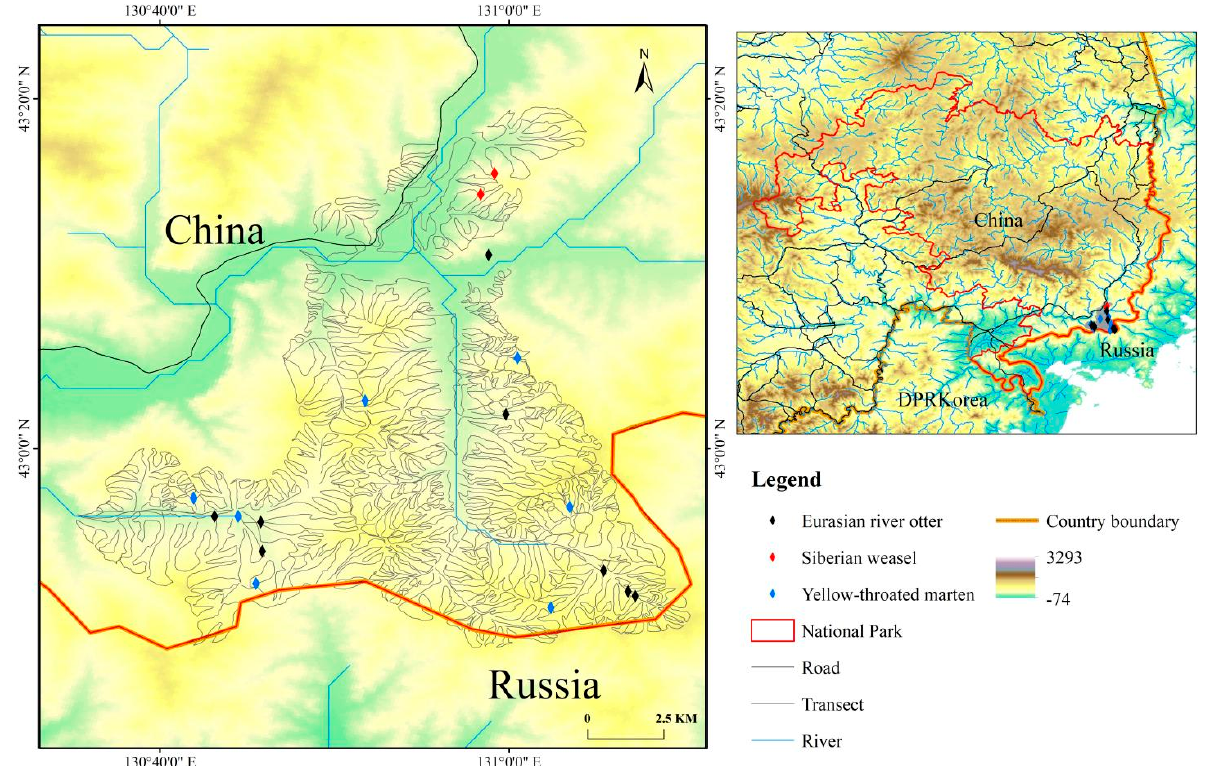
Figure 1. Location and habitat of the study area in the Northeast Tiger Leopard National Park in Northeast China. Different symbols indicate the localities of individual fecal samples from the mesopredators species used in the diet metabarcoding analysis.